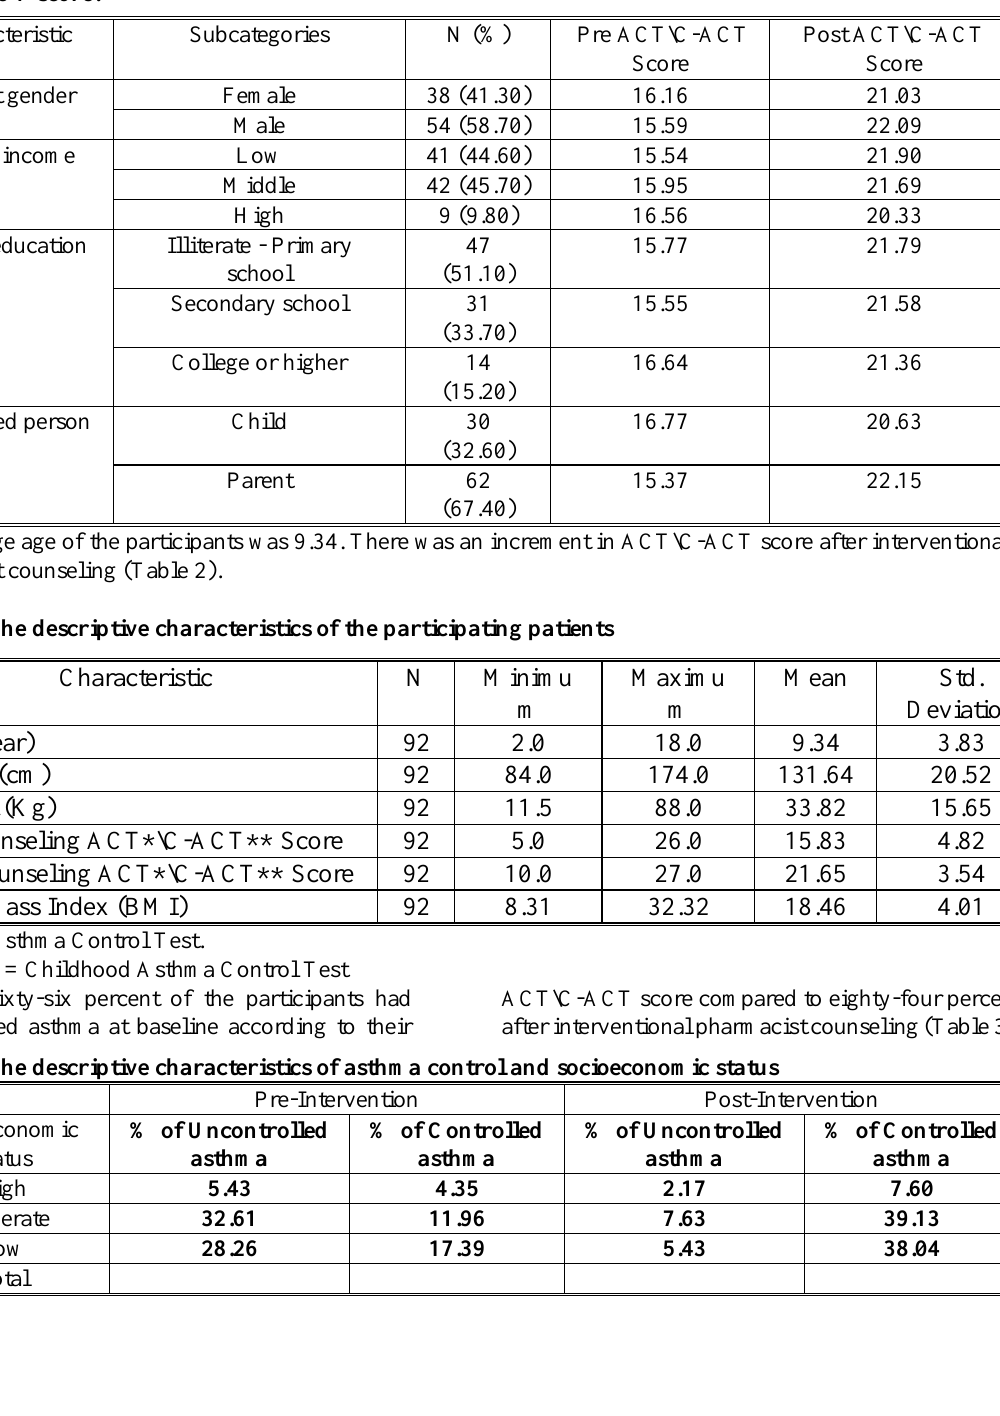
Table 1. The characteristics of the participants/guardian of the participants and their average pre and post ACT\C-ACT score.